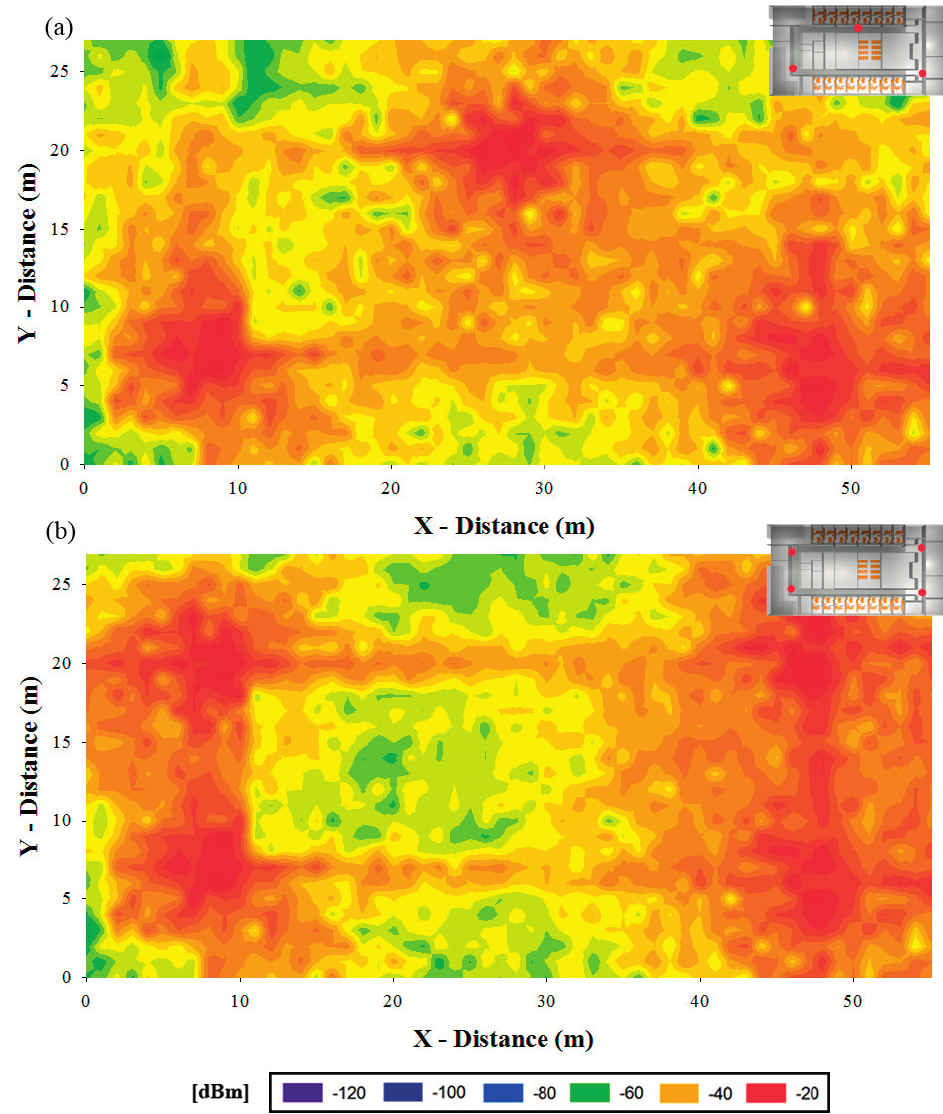
Figure 7. Preliminary distribution of antennas where three ( a ) and four ( b ) antennas have been